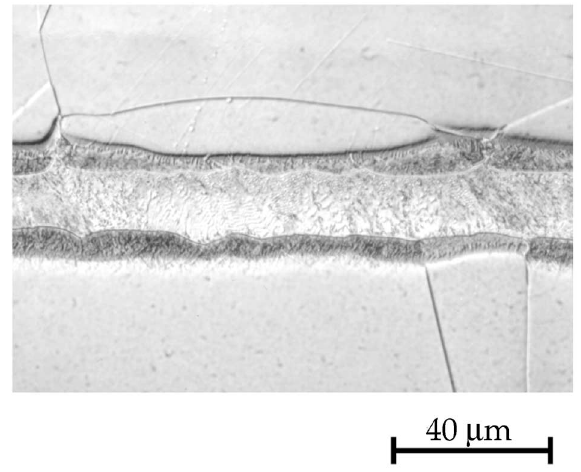
FIG. 6. Microstructure of a pure silver PVD vacuum furnace braze showing the eutectic liquid braze. 053502-6